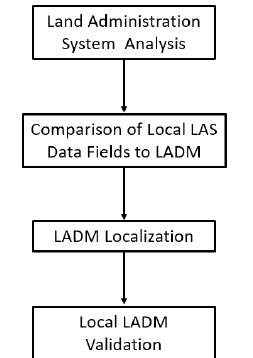
Figure 2 . LADM adoption